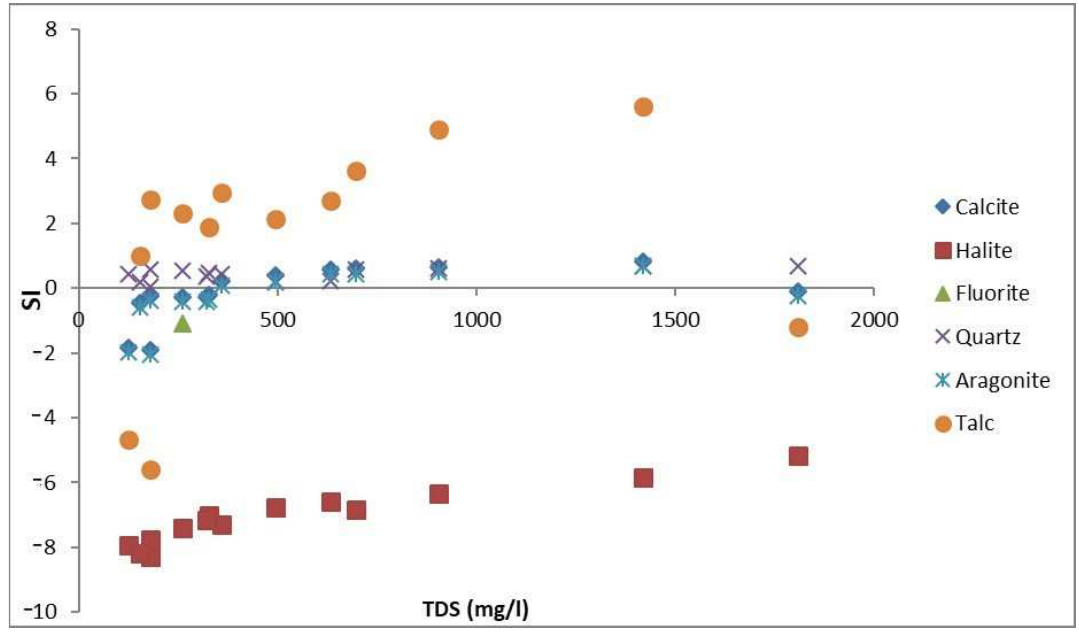
Figure 9. Saturation index of minerals of water collected in the Soutpansberg region.